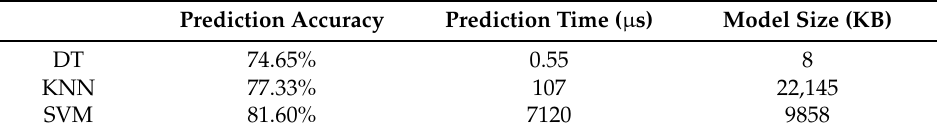
Table 2. General accuracy of each algorithm with seven features based on Reference [5].